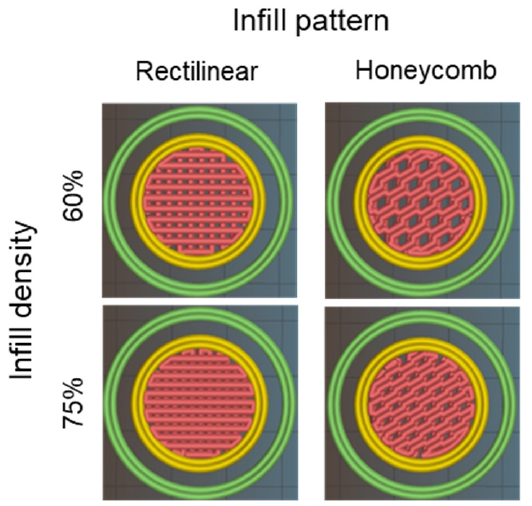
Figure 11. Slic3r software preview of disk-shaped 3D model with different printing process parameters configured.